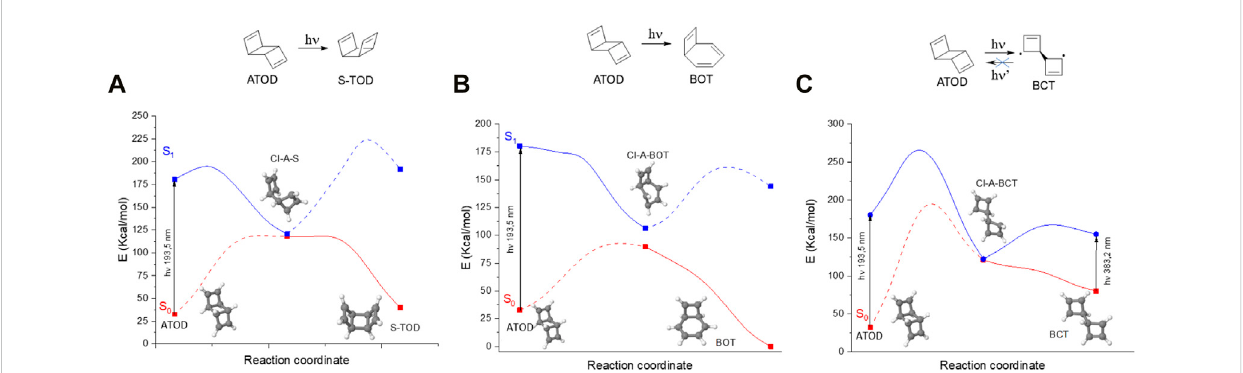
FIGURE 4 Different CASSCF photochemical pathways initiated by ATOD S 0 → S 1 photon absorption: (A) ATOD → STOD, (B) ATOD → BOT, (C) ATOD → BCT, and their respective internal conversion. Energy graphs are shown in adiabatic fashion (S 0 : red and S 1 : blue) with the continuous lines corresponding to the populated potential energy surfaces necessary to reach the respective photoproduct. Geometrical structures of S 0 minima and S 1 /S 0 conical intersections are also shown.